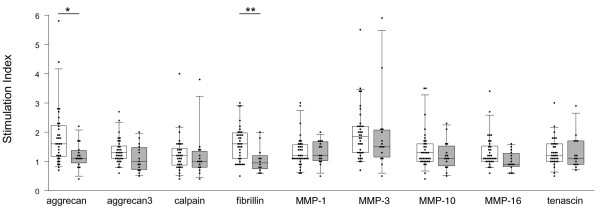
T-cell proliferative responses in patients with juvenile idiopathic arthritis (JIA) and healthy controls. Proliferative responses are presented as interquartile range for each group of data, with horizontal lines showing the median. The aggrecan and fibrillin peptides induced significant differences in responses of peripheral blood mononuclear cells (PBMC) from patients with JIA and healthy controls and are indicated as follows: **p = 0.005, *p = 0.015. The matrix metalloproteinase (MMP)-3 peptide induced proliferative responses in PBMC of patients with JIA as well as in PBMC of controls. Transparent boxes: JIA; gray boxes: healthy controls.